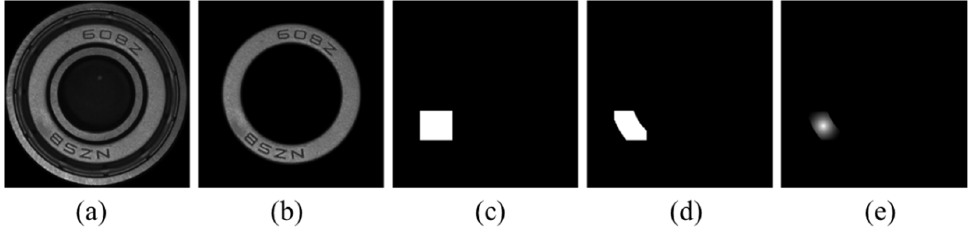
Figure 5. The weight label for segmentation networks. ( a ) original image; ( b ) region of interest; ( c ) annotation label; ( d ) semi-fine label; ( e ) weight label.